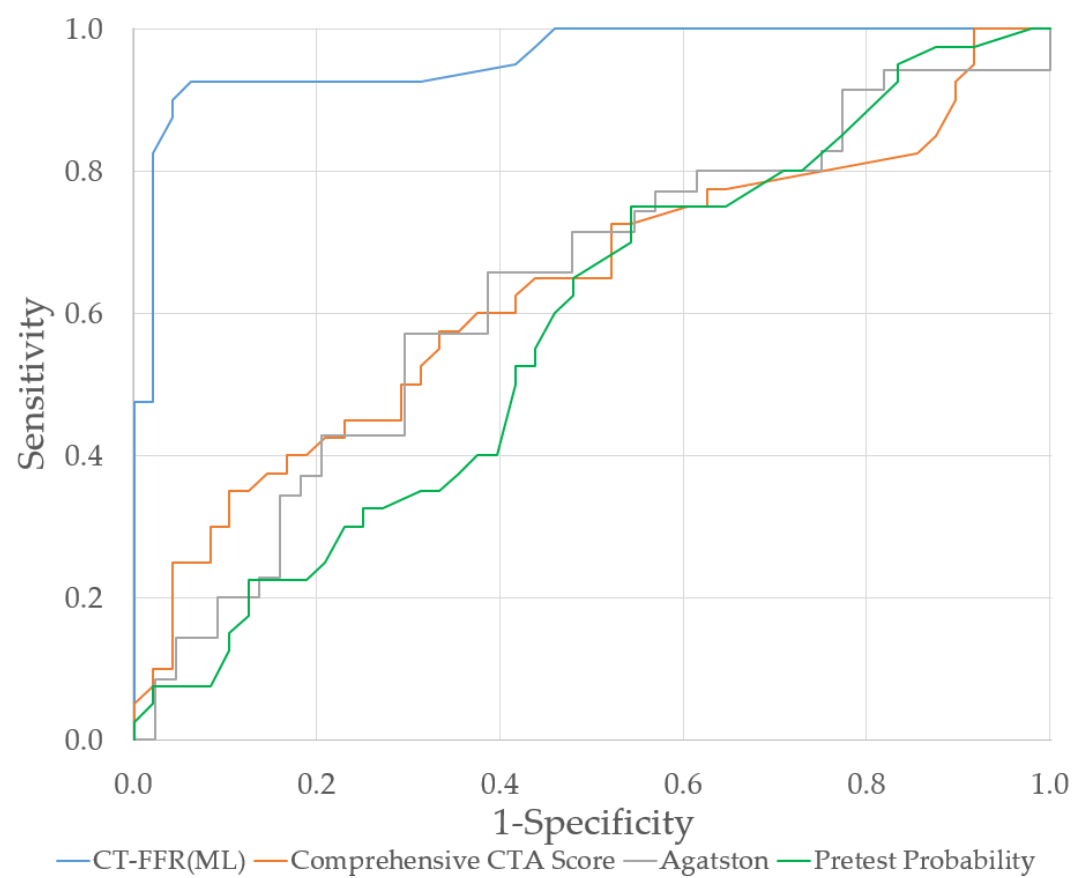
Figure4. ROC-curveofpretestprobability, Agatstonscore, thecomprehensiveCTAscoreandCT-FFR ML Figure 4. ROC-curve of pretest probability, Agatston score, the comprehensive CTA score and CT- 257 FFR ML . 258